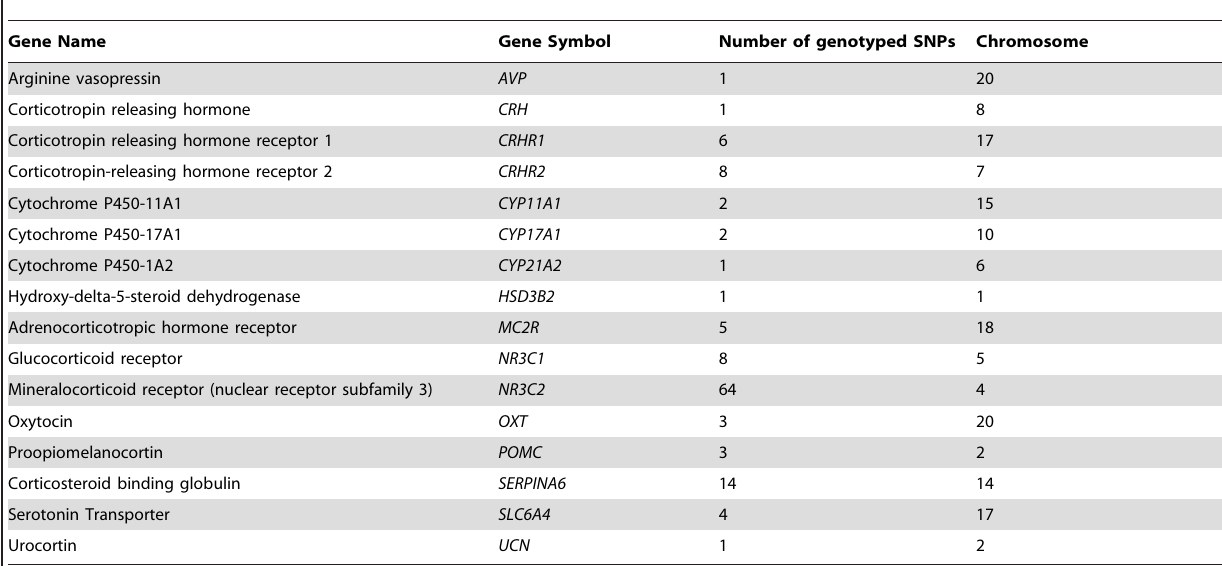
Table 1. List of genes, corresponding gene symbols, and number of SNPs in each gene genotyped in the Western Australia Pregnancy Cohort (Raine)